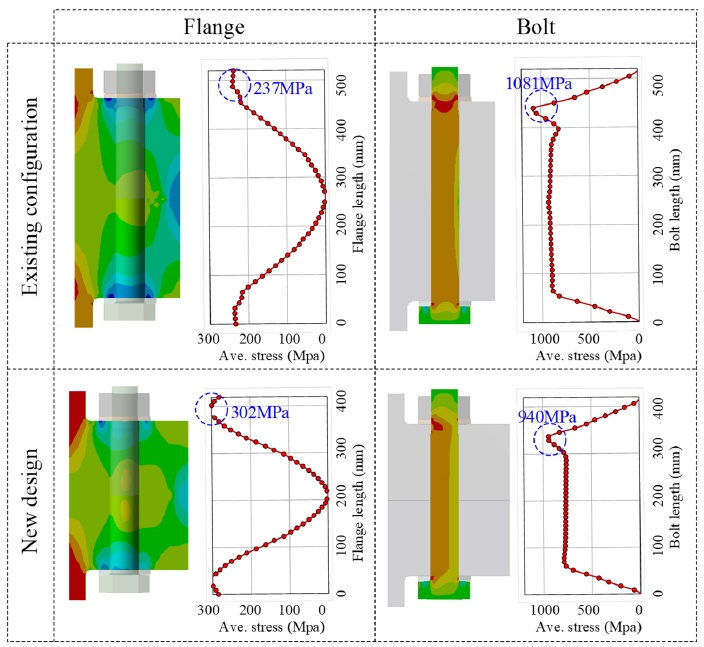
Figure 14. Stress distribution under F s = 050 kN.